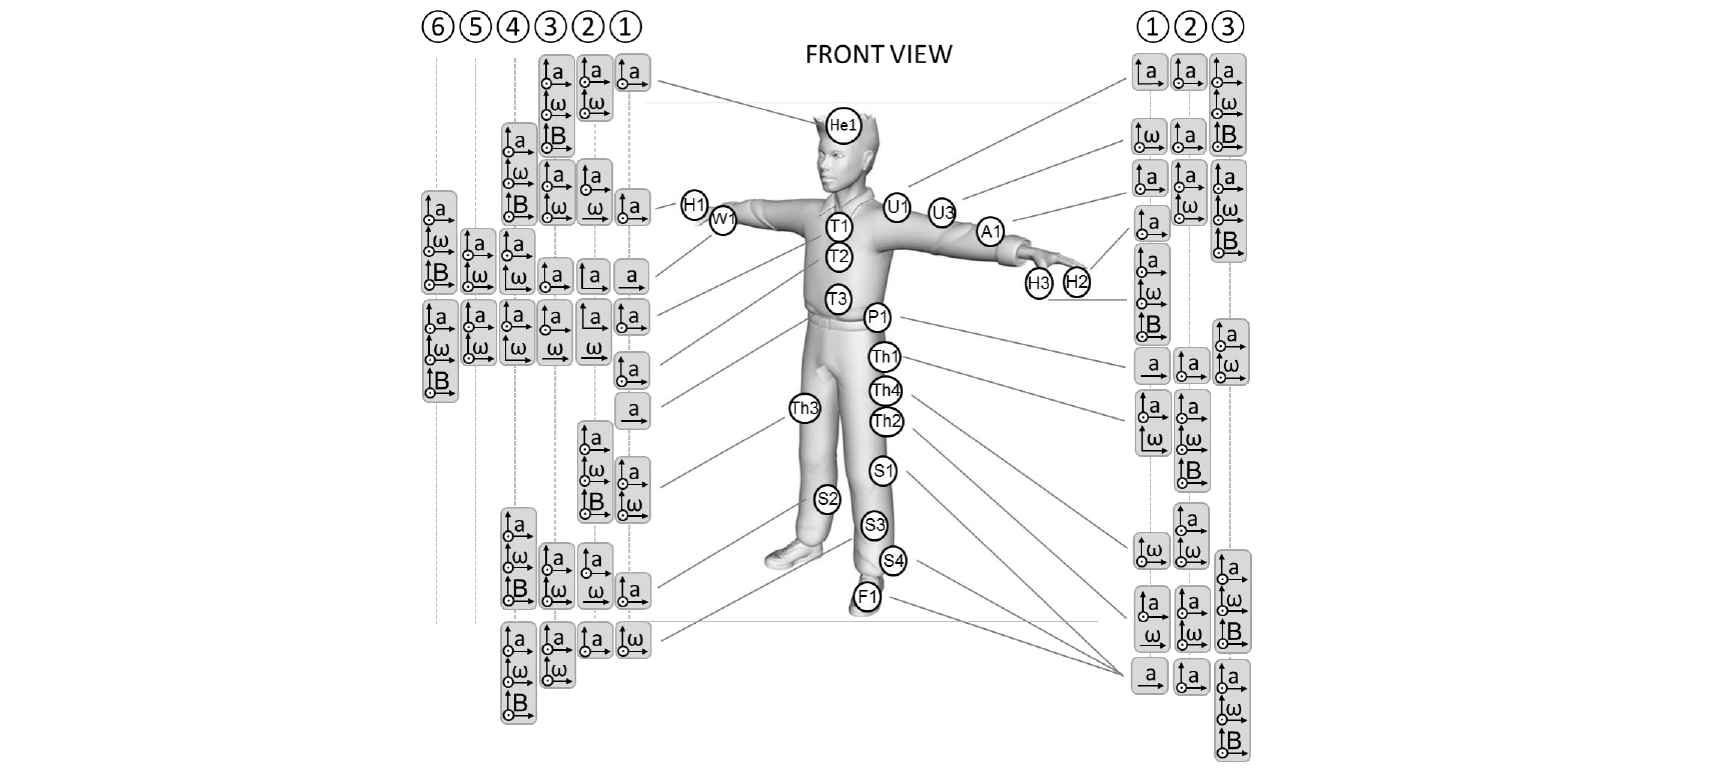
Table 5. Sensors’ positions and configurations on the athlete’s body (front and back views). The different positions are coded with specific body segment capital letters (C—chest-back; U—upper arm; A—forearm; W—wrist; H—hand; P—pelvis; T—thigh; S—shank; F—foot) and numbers (to distinguish different positions for the same body segment). The different configurations are specified in terms of type of device (accelerometer, gyroscope, magnetometer) and number of dimensions (one-, two-, three-dimensional). Each configuration is reported in a different column.